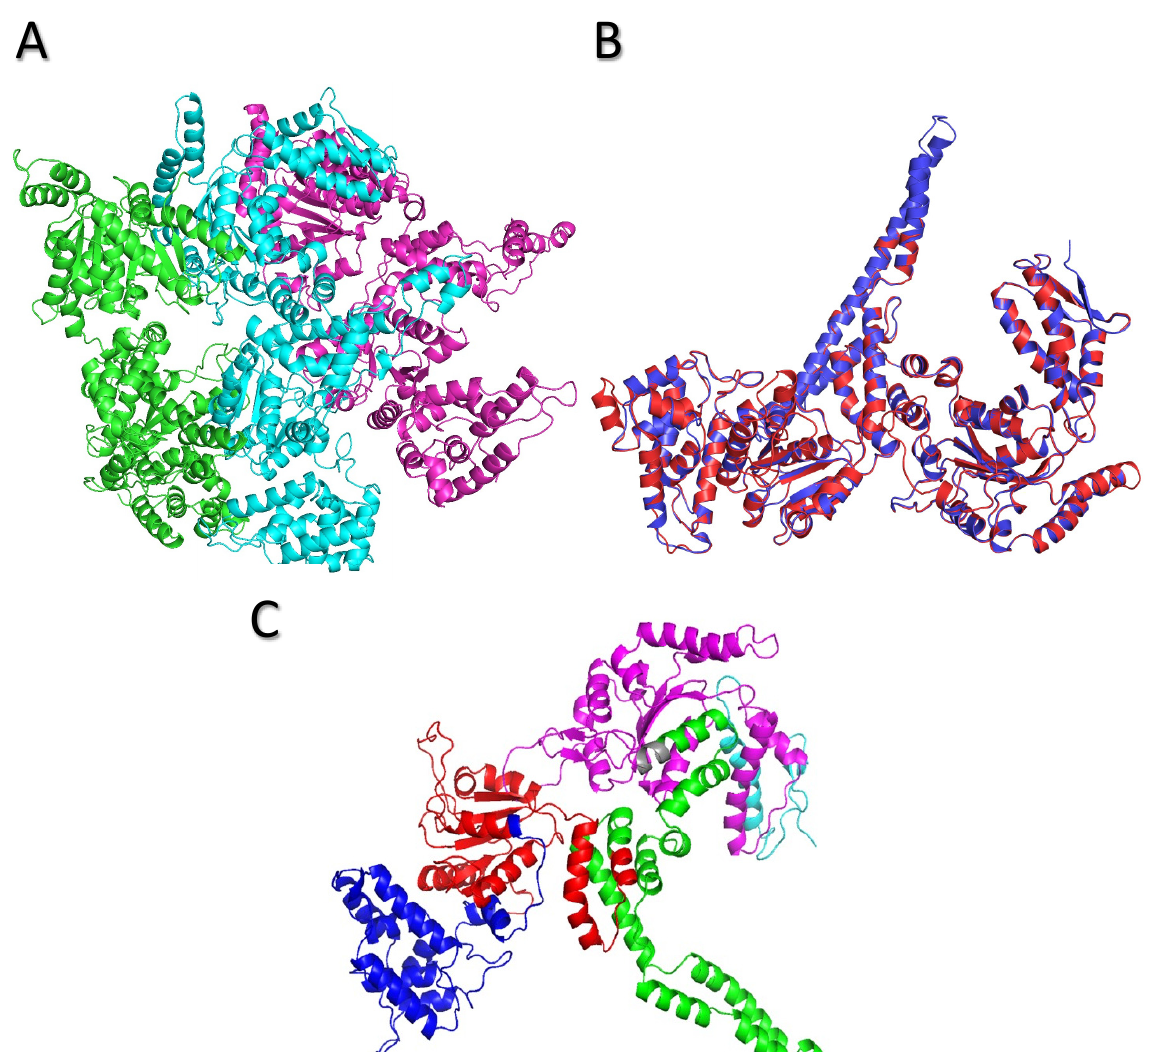
Figure 6. Hypothetical ClpK structure modelled using ClpB as a template. ( A ) Secondary trimeric structure of ClpK with chains A, B, and C shown as green, cyan and pink, respectively. ( B ) Superimposed monomeric secondary structure of ClpK (red) and ClpB (1QVR-B) template (blue). ( C ) Secondary structure elements of ClpK domains colored as follows: Blue; N-terminal domain, red; D1 large domain, green; D1 small domain, grey; short linker region, pink; D2 large domain, light blue; D2 small domain/C-terminal domain. The structures were refined using OPLS_2005 force field and visualized using PYMOL [35,36] .